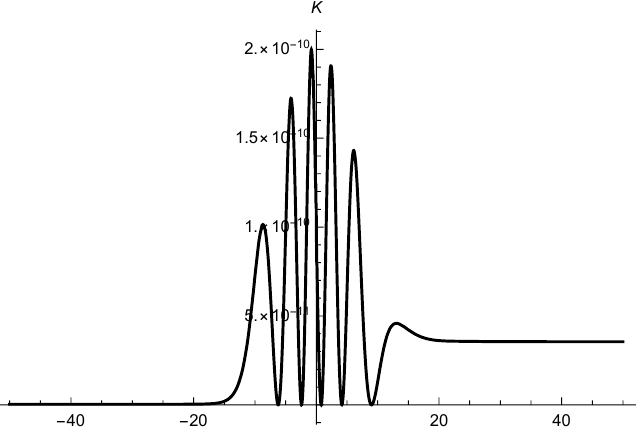
Figure 5. K ( u ) , considering H 1 , the initial conditions III and λ = 7.30247.